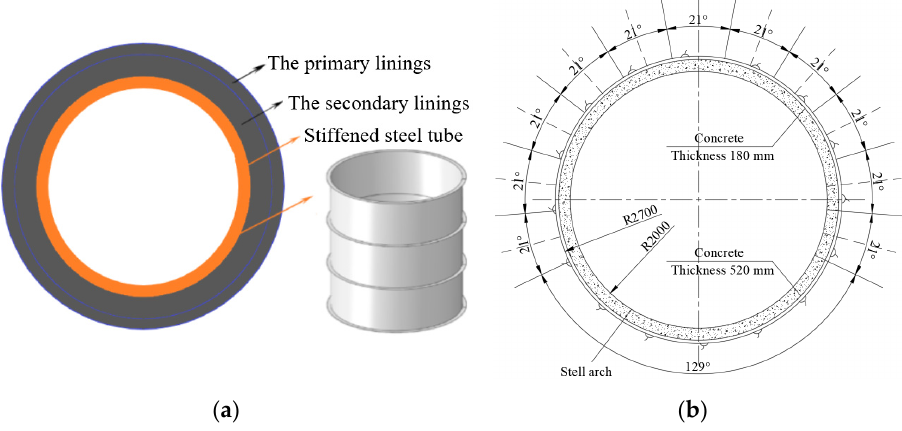
Figure 1. Schematic diagram of the composite lining structure: ( a ) Composite lining structure; ( b ) Tunnel supporting system constructed by drilling and blasting method.